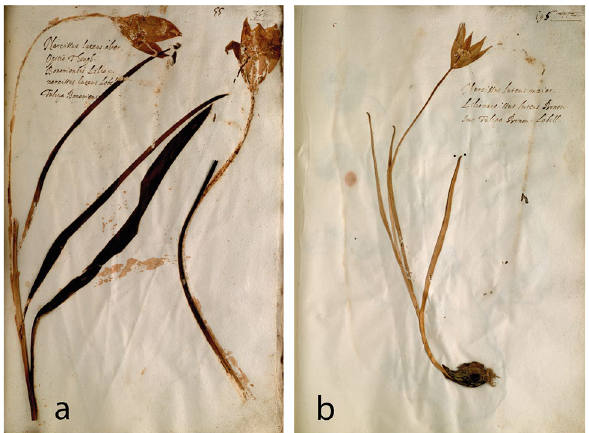
Figure 4. The oldest surviving specimens of Tulipa sylvestris. They are contained in the herbarium of Ulisse Aldrovandi ( a ): 1552, vol. IV, c. 55r, ( b ): 1553, vol. VI, c. 195r. Orto Botanico & Erbario, Universita di Bologna.